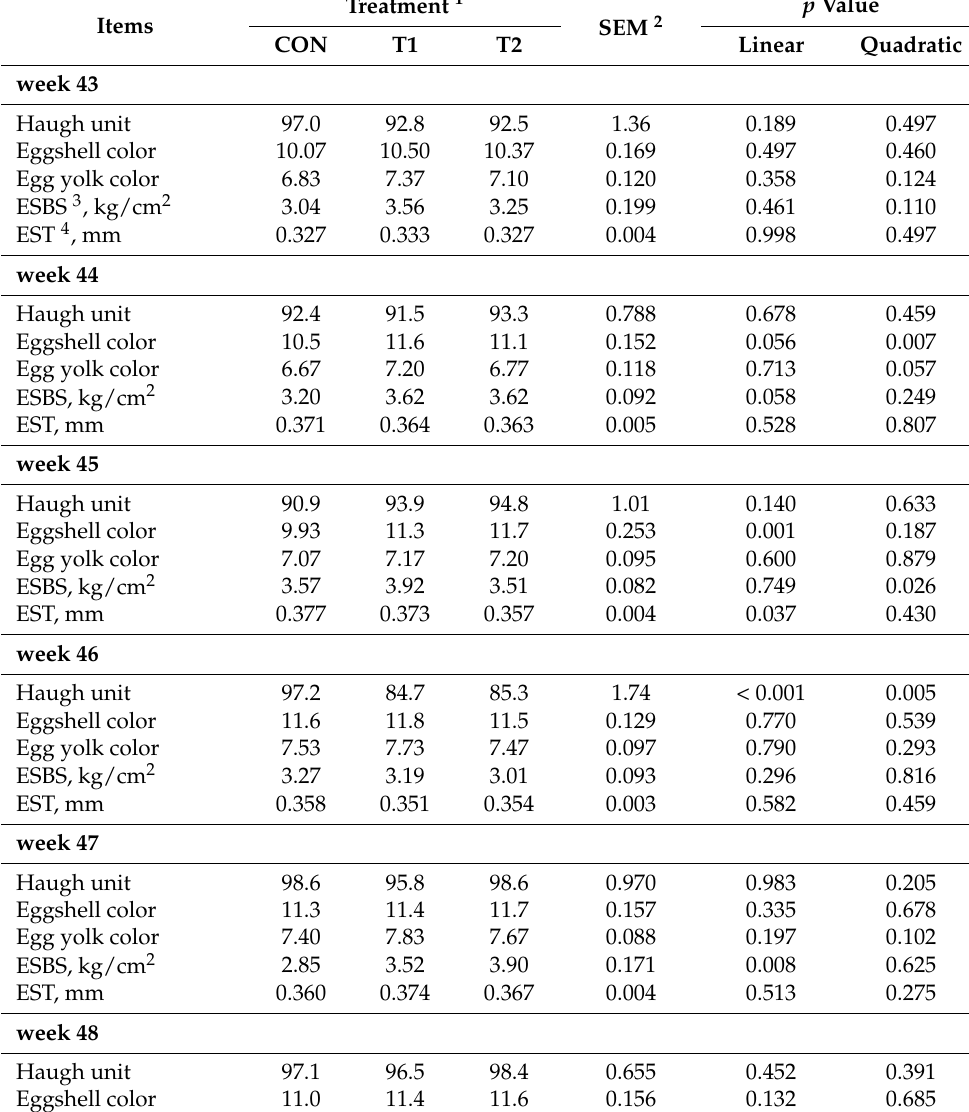
Table 5. Supplementary effect of fermented pine needle extract in egg quality of laying